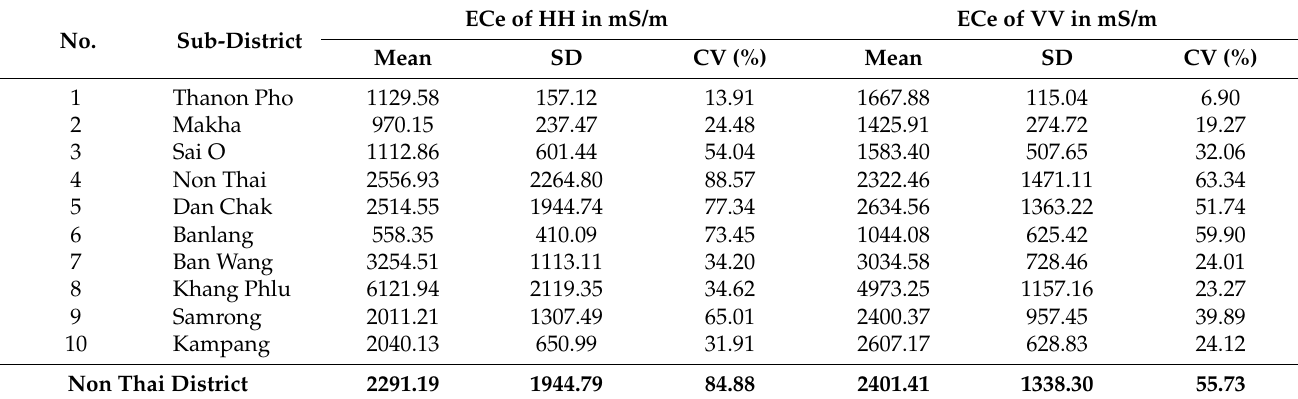
Table 10. Statistical data of soil salinity prediction using OK of two modes by sub-district.